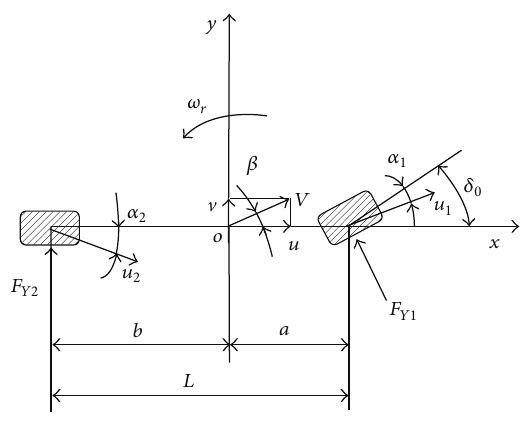
Figure 1: 2-DOF vehicle model.